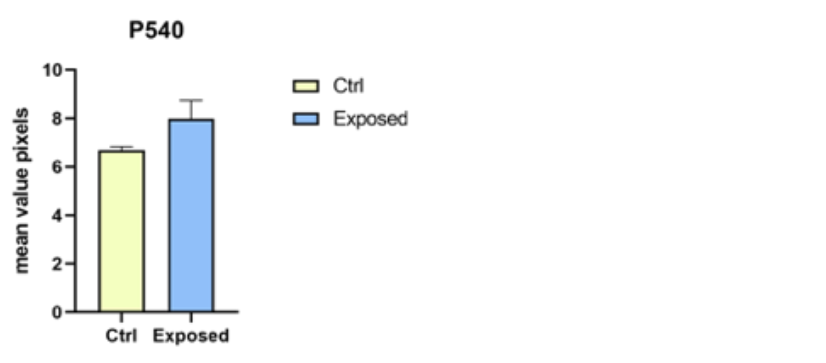
Figure 7. Statistical analysis for P540 biomarker between the control group and larvae exposed to 27 GHz (no statistically significant difference was found for p < 0.05).